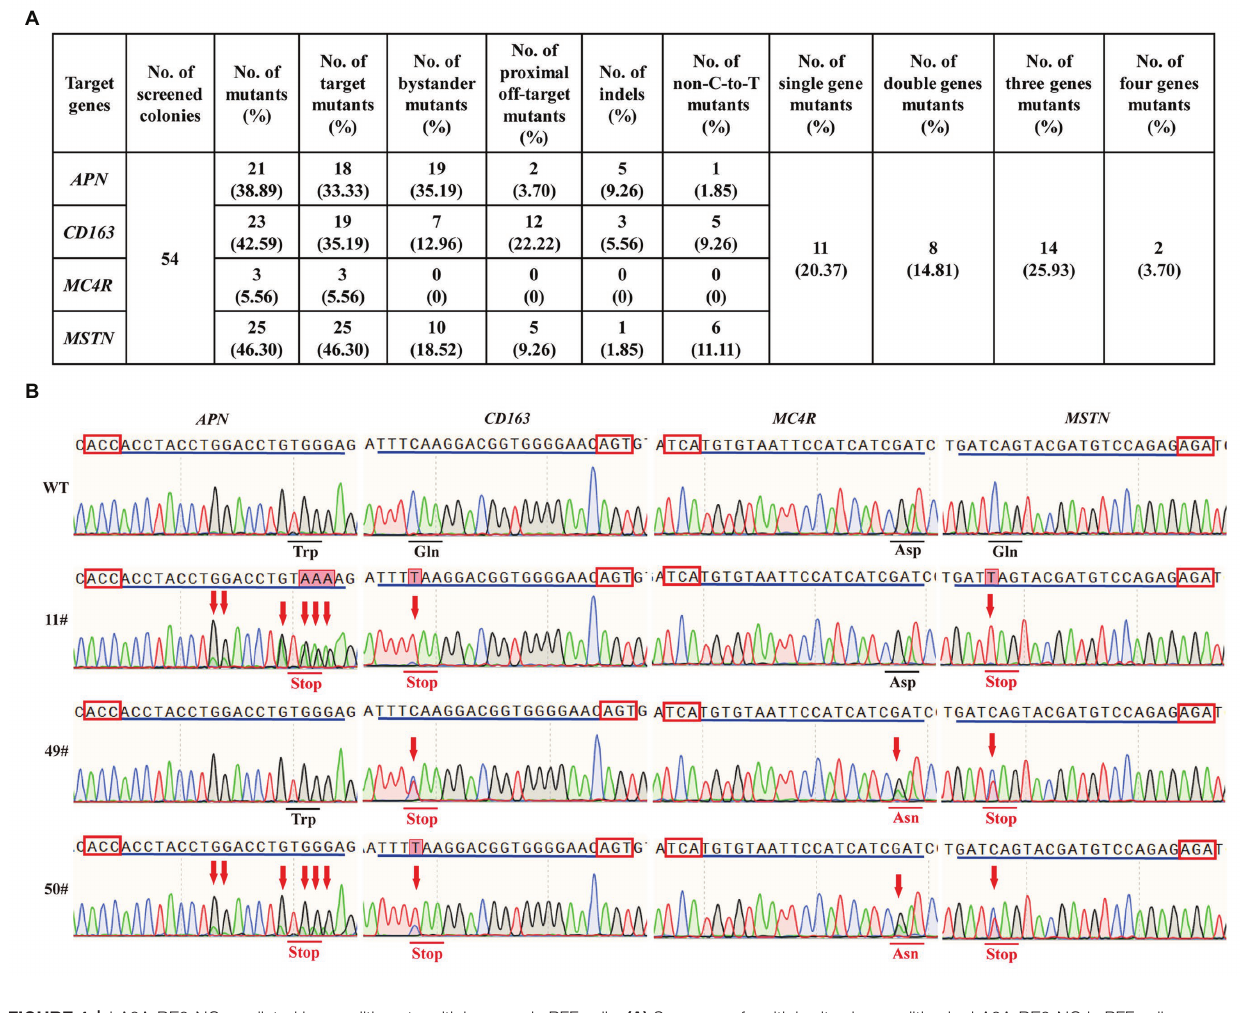
FIGURE 4 | hA3A-BE3-NG-mediated base editing at multiple genes in PFF cells. (A) Summary of multiple sites base editing by hA3A-BE3-NG in PFF cells. (B) Sanger sequencing results of selected single-cell colonies. 11# and 49# colonies have mutations on three genes, and 50# colony has mutations on all four genes. The red box indicates the PAMs and the blue line indicates the sgRNA sequence. The red arrow indicates the substituted nucleotide. The amino acid in the red line indicates expected substitutions at target